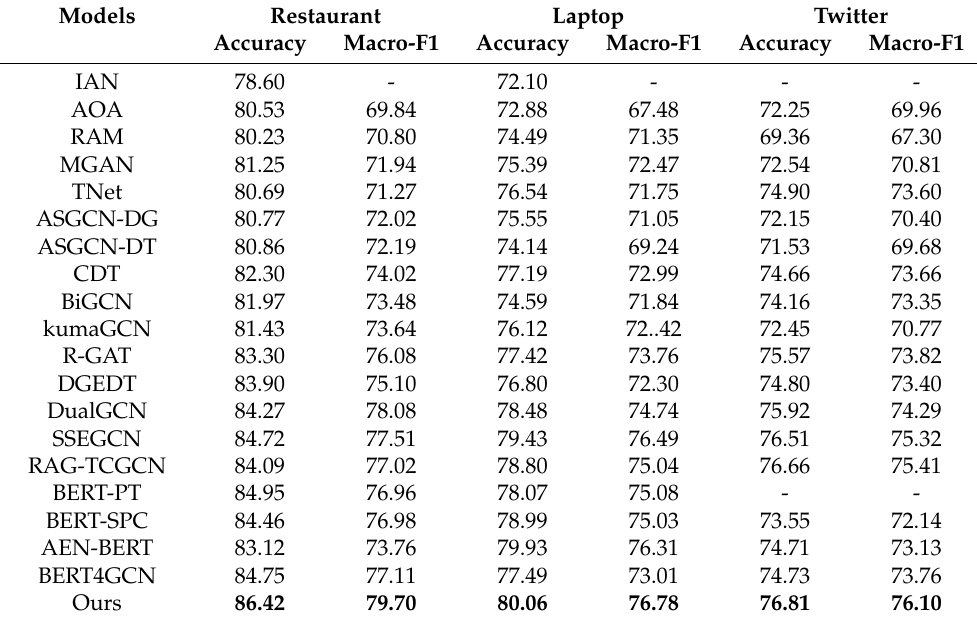
Table 4. Sentiment classification results. We directly introduce the result data from the original author’s paper as the data for comparison, where “-” means that this part of the work is not revealed, and the best experimental results are shown in